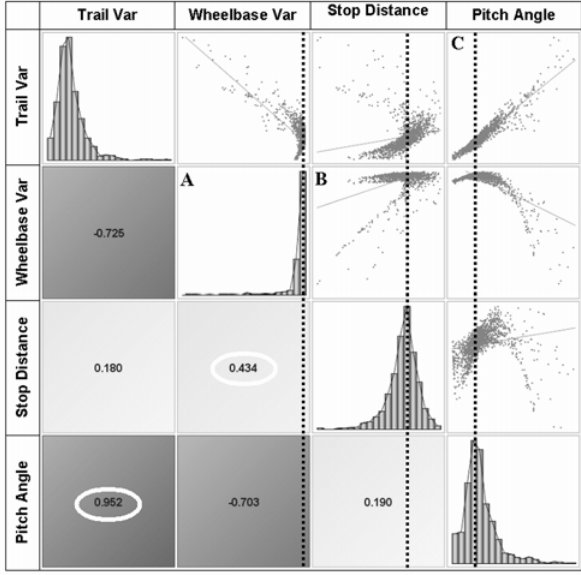
Fig. 5. Correlation matrix for the objectives